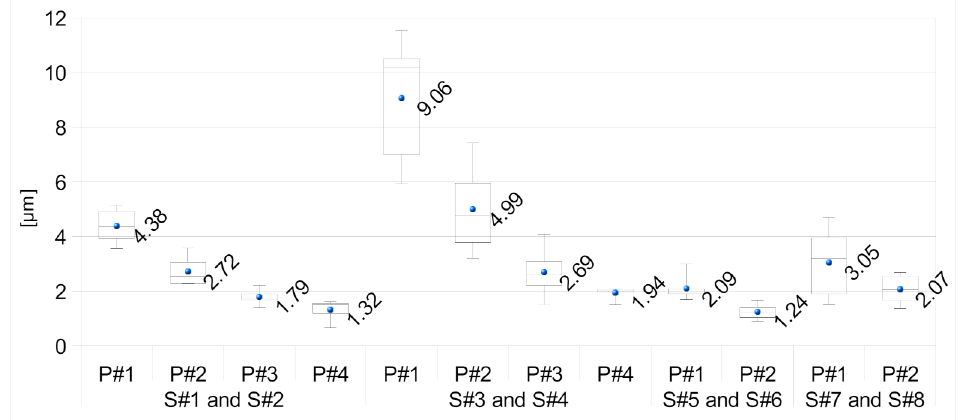
Figure 7. The center and spread of a maximum height of the waviness profile (Wz) of the samples under investigation (the box plot presents the mean, the median, the interquartile range box, and the range of the